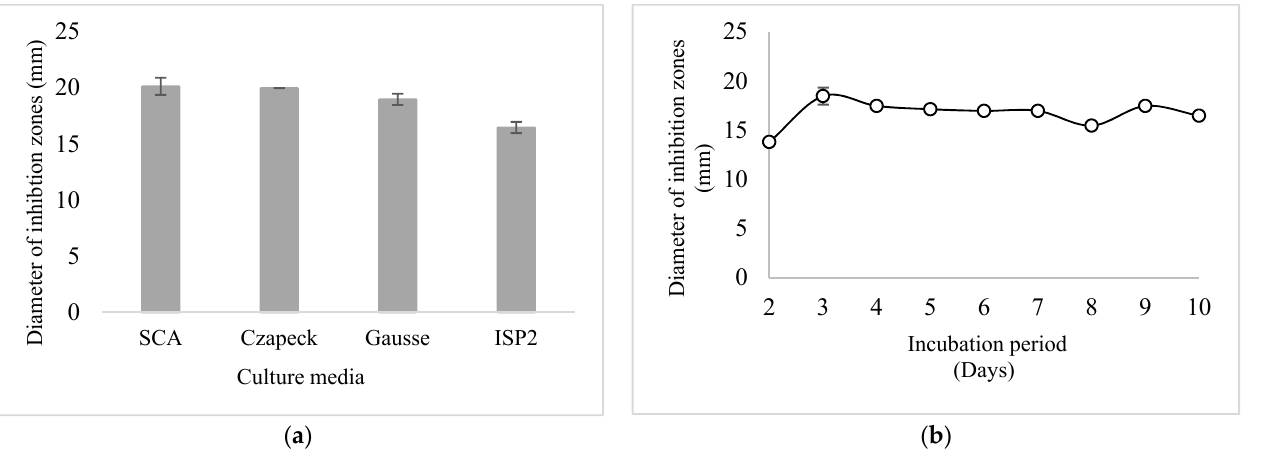
Figure 3. Anti-MRSA activity variation ( a ). Kinetics of anti-MRSA compounds production ( b ).